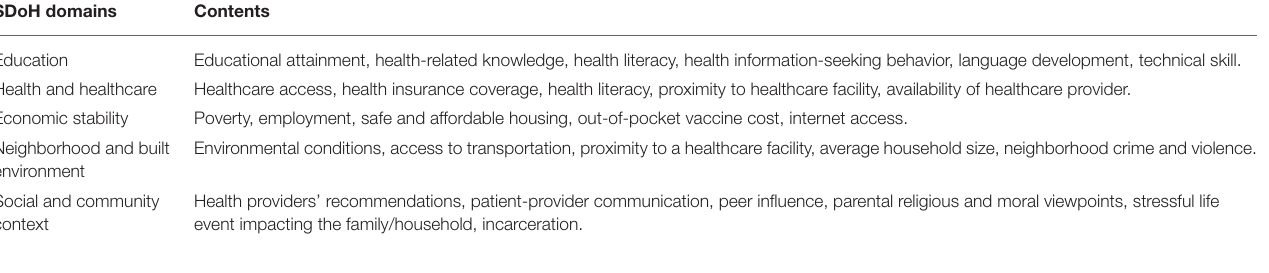
TABLE 1 | Barriers to vaccine uptake based on the CDC’s classification of the SDoH domains.